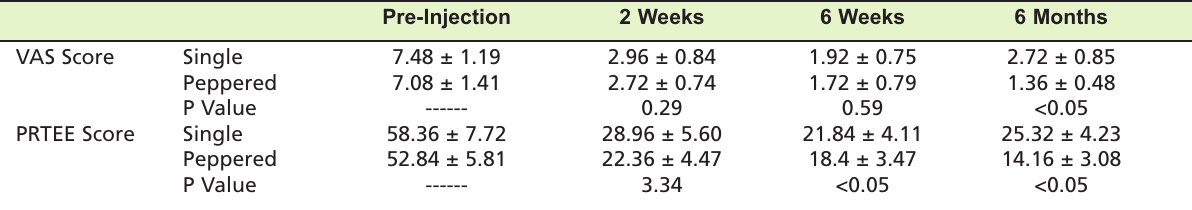
Comparison of VAS and PRTEE Scores between single and peppered injection groups Table I: